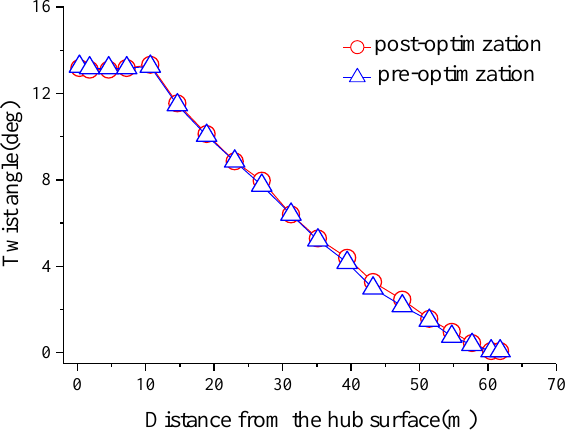
Figure 5. Distribution of the twist angle for fixed wind turbine blade at rated wind speed before and after optimization.